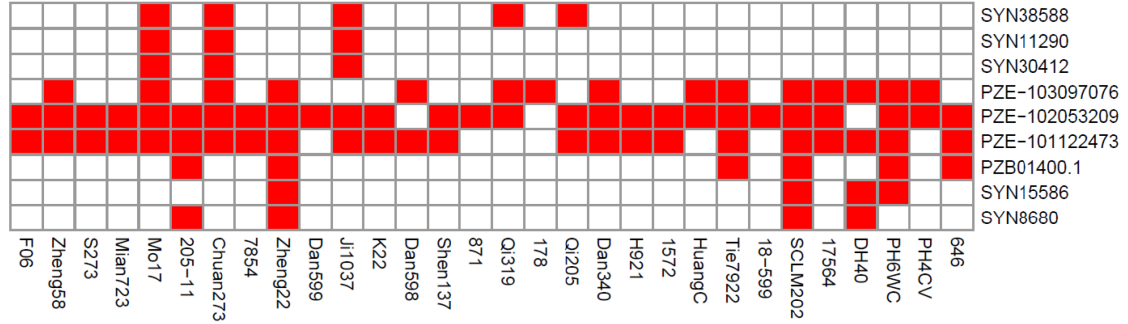
Figure 4. Superior allele distributions of nine SNPs in 30 elite inbred lines. Red and white colors represent superior and inferior alleles, respectively.